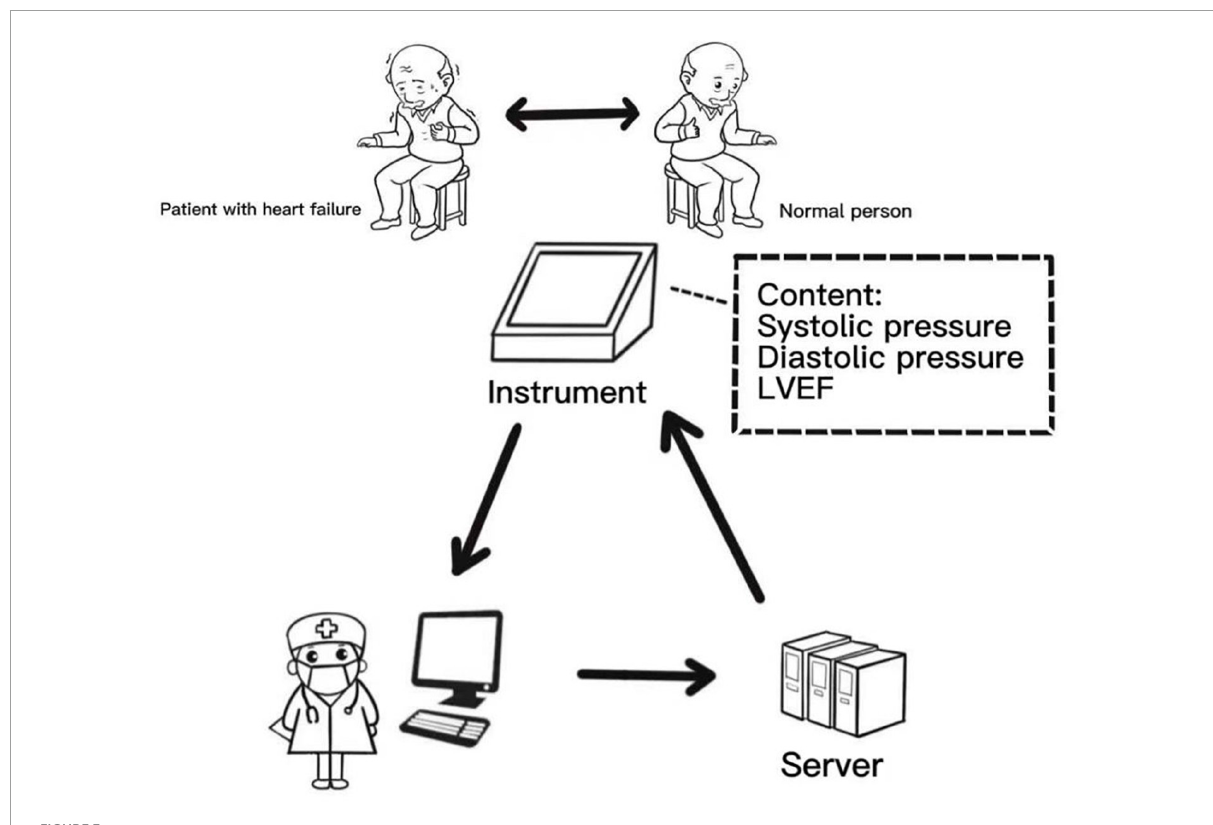
FIGURE3 Schematic diagram of operation mode of future intelligent